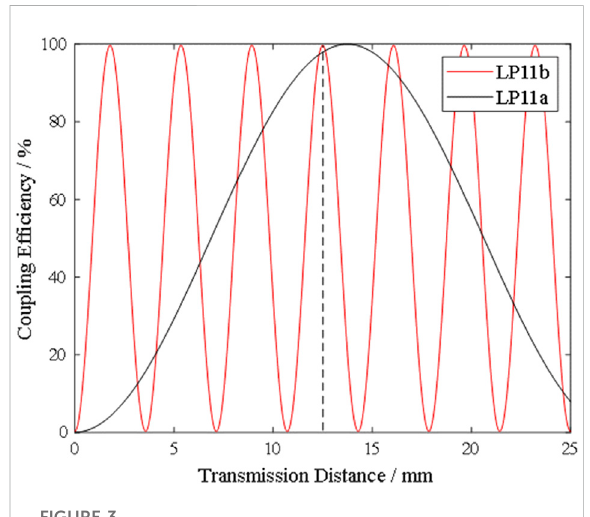
FIGURE 3 Variation of coupling ef fi ciency of the output modes LP11a/ LP11b in the TMF1 in the case of the input modes LP11a/LP11b in the FMF.